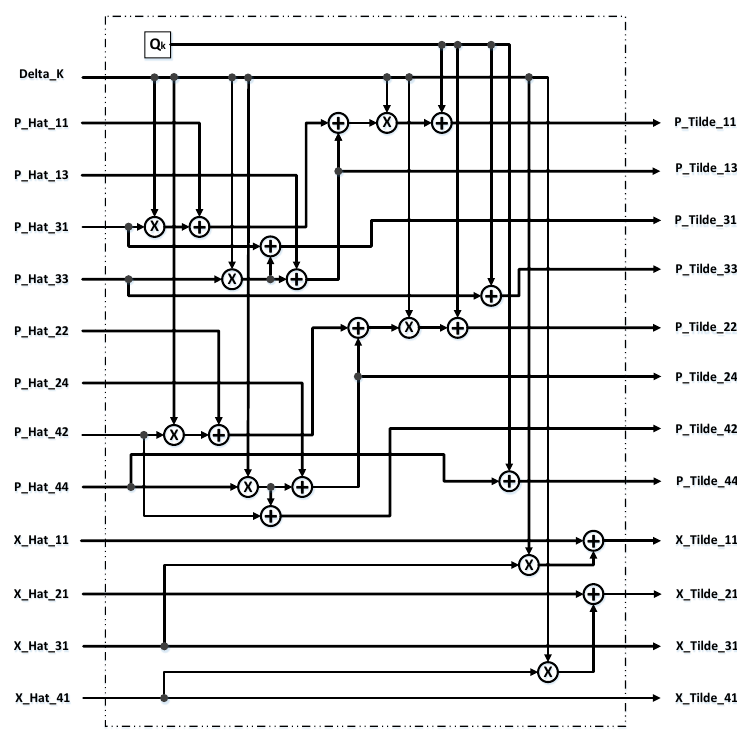
Figure 8. VLSI architecture of the predicted state module.